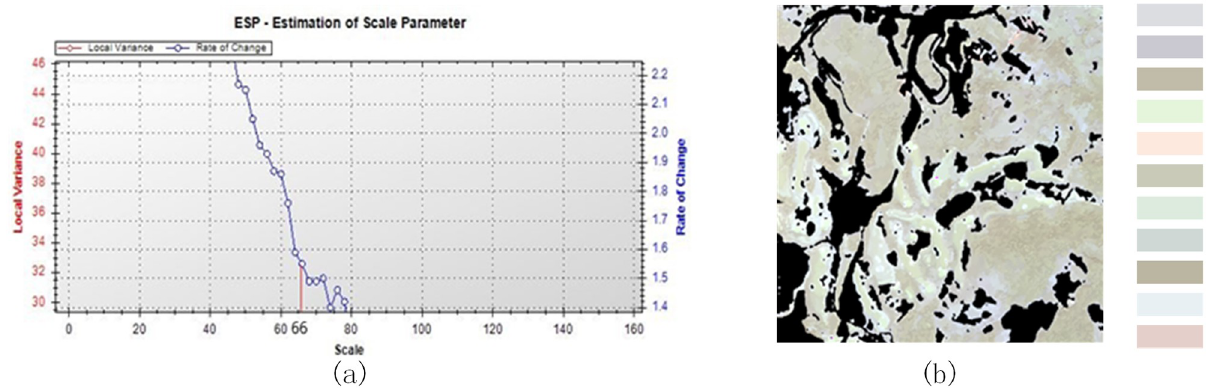
Fig 7. Multiresolution segmentation (SS = 66, WS_1 = 0.5, WC = 0.1): (a) variance curve and (b) image object.